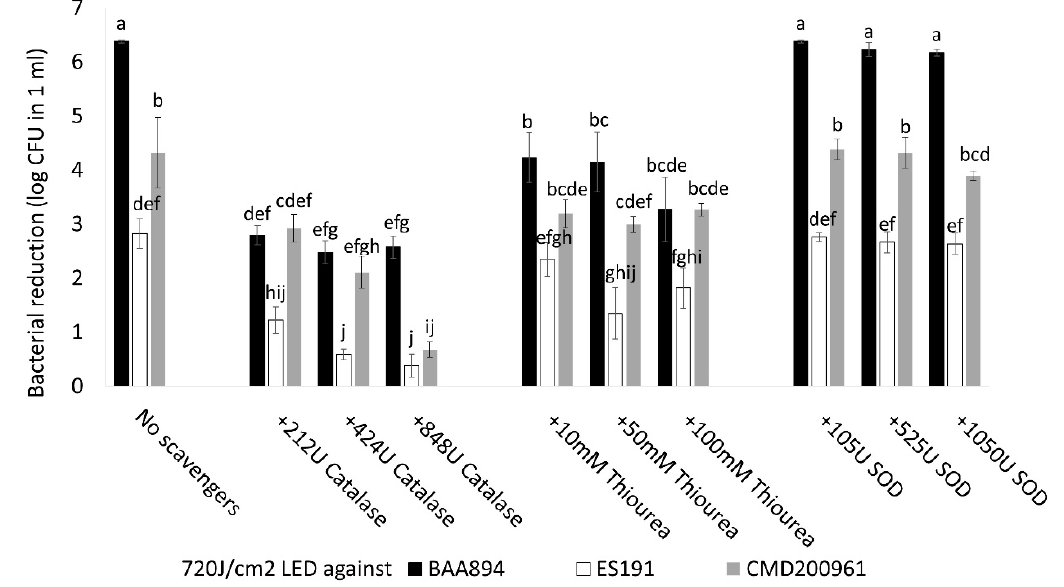
Figure 4. The effects of different ROS scavengers on bacteria log reduction during 720 J/cm 2 of light treatment. Groups that do not share a letter are significantly different.